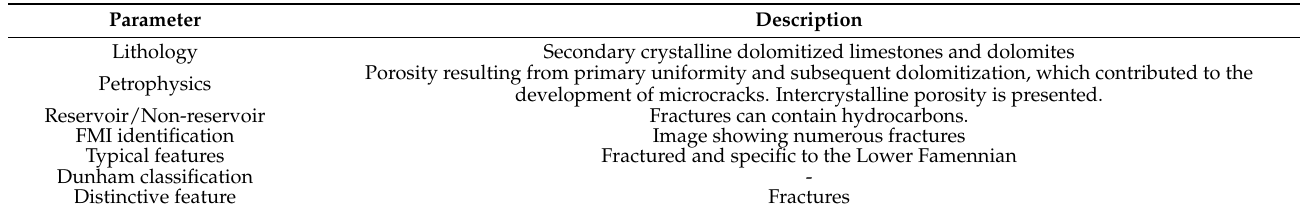
Table 7. Description of main reservoir parameters for